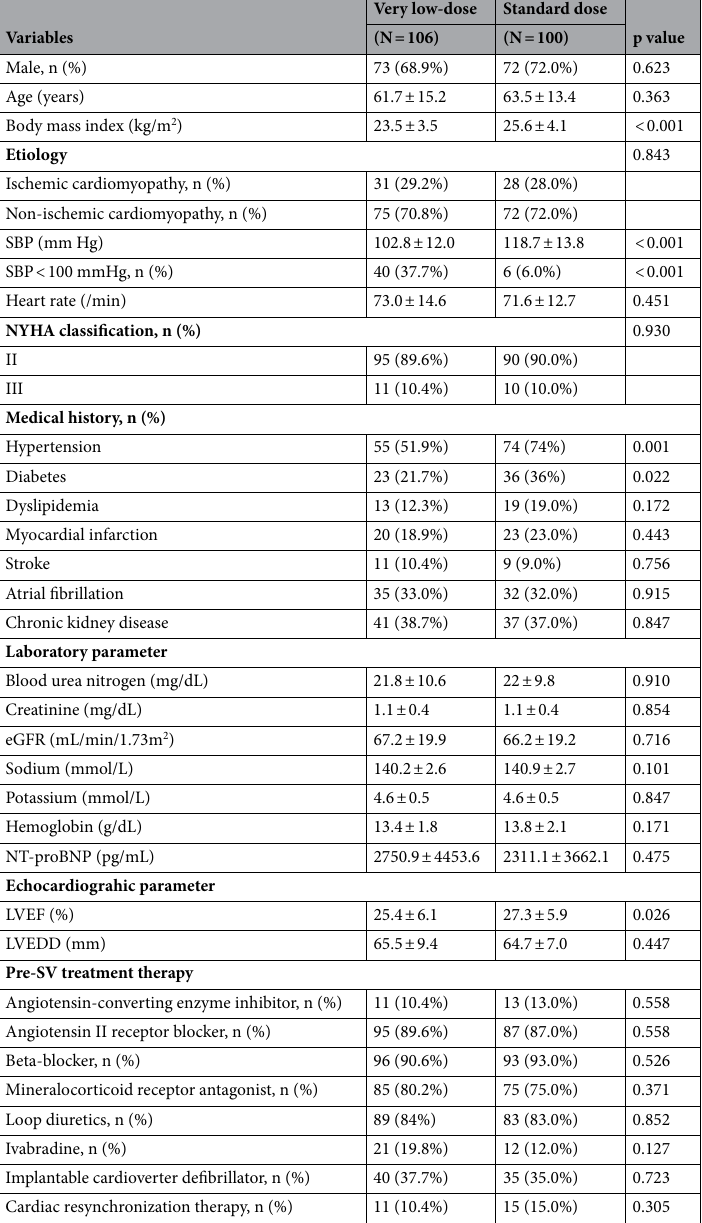
Table 1. Baseline characteristics. SBP systolic blood pressure, NYHA New York Heart Association, LVEF left ventricular ejection fraction, eGFR estimated glomerular filtration rate, NT-proBNP N-terminal prohormone of brain natriuretic peptide, SV